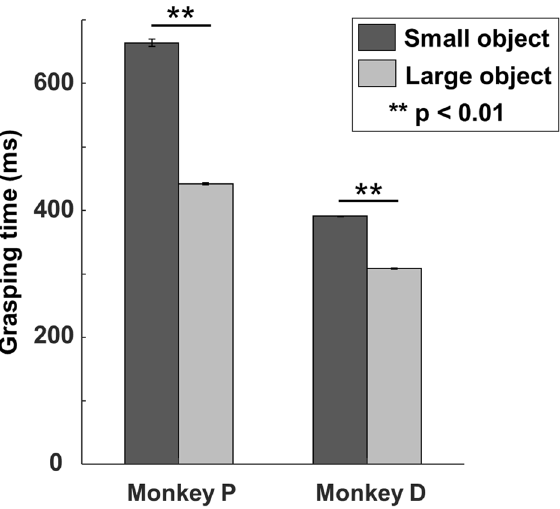
Figure 1. Baseline grasping times. Bar plot representing the GTs measured for each monkey, separately during the 4 baseline sessions performed with the small (black) and the large object (grey). Our data confirmed Fitts’ law, showing significantly longer GTs when grasping the small object. Asterisks indicate statistical significance (two-sided Wilcoxon Ranksum test; **: p <